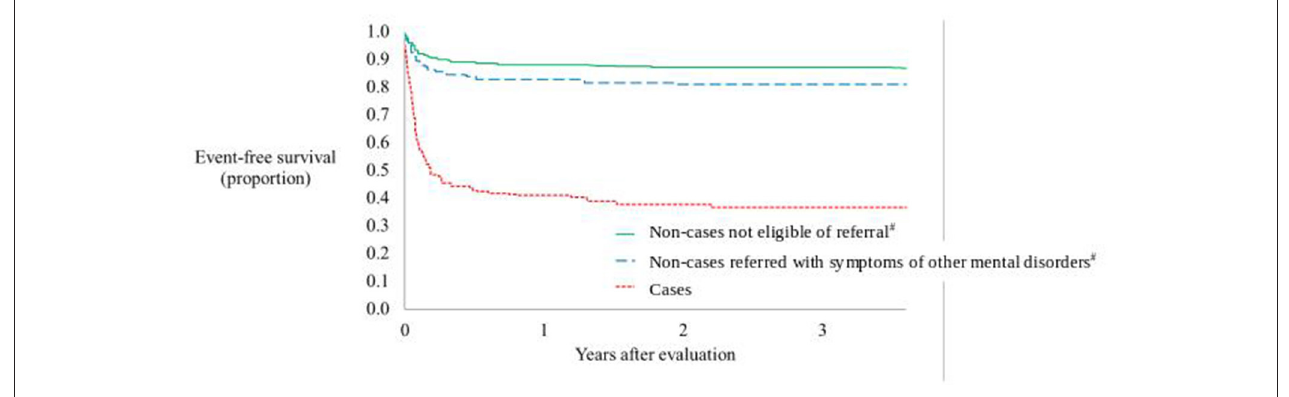
FIGURE 2 | Non-affective psychotic disorder-free period after assessment by the early detection team. # Non-cases are divided into non-cases not eliglible for refferal in mental health services and non-cases referred with symptoms of other mental disorder than